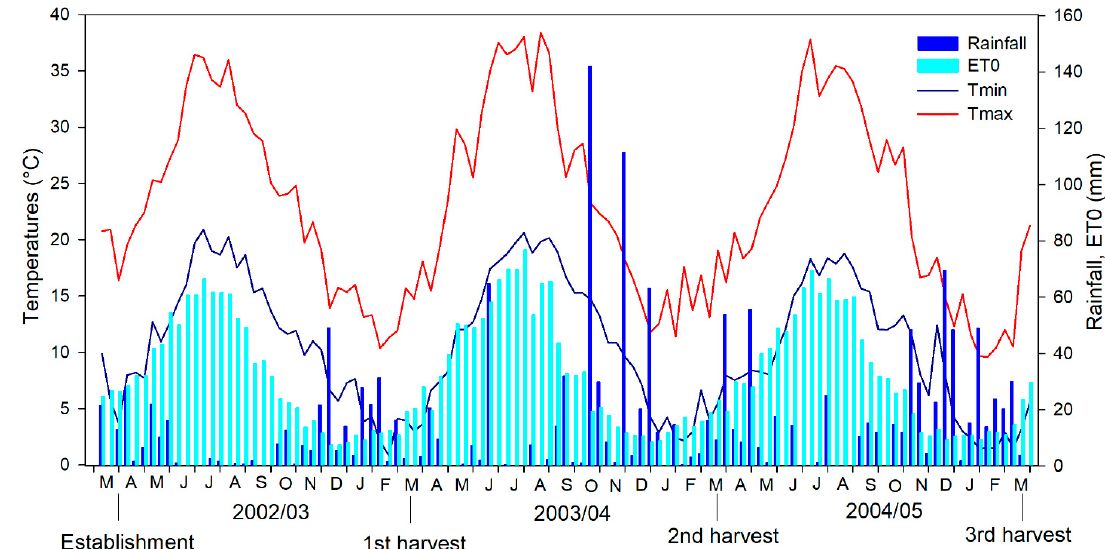
Figure 1. Meteorological trends, maximum (Tmax) and minimum (Tmin) air temperature (°C), rainfall and reference evapotranspiration (ET 0 , mm) at the experimental site (37°23 ′ lat. N, 14°21 ′ long. E, 450 m a.s.l.) during 2002/03, 2003/04, and 2004/05 growing seasons.